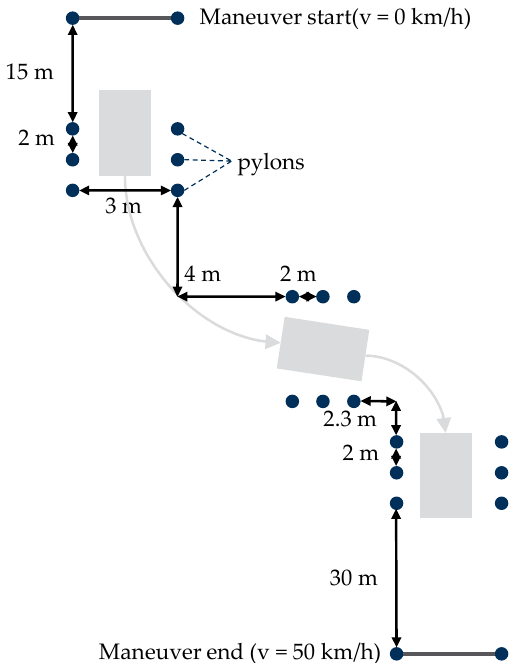
Figure 5. Schematic representation of Maneuver A (not to scale).